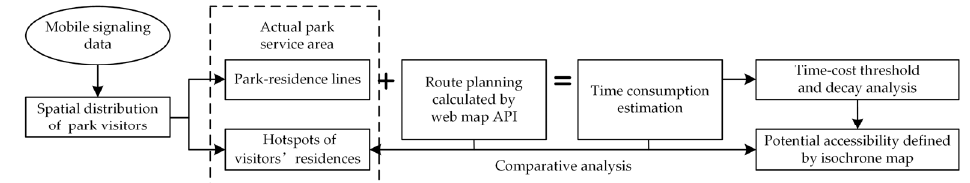
Figure 1. Research frame.